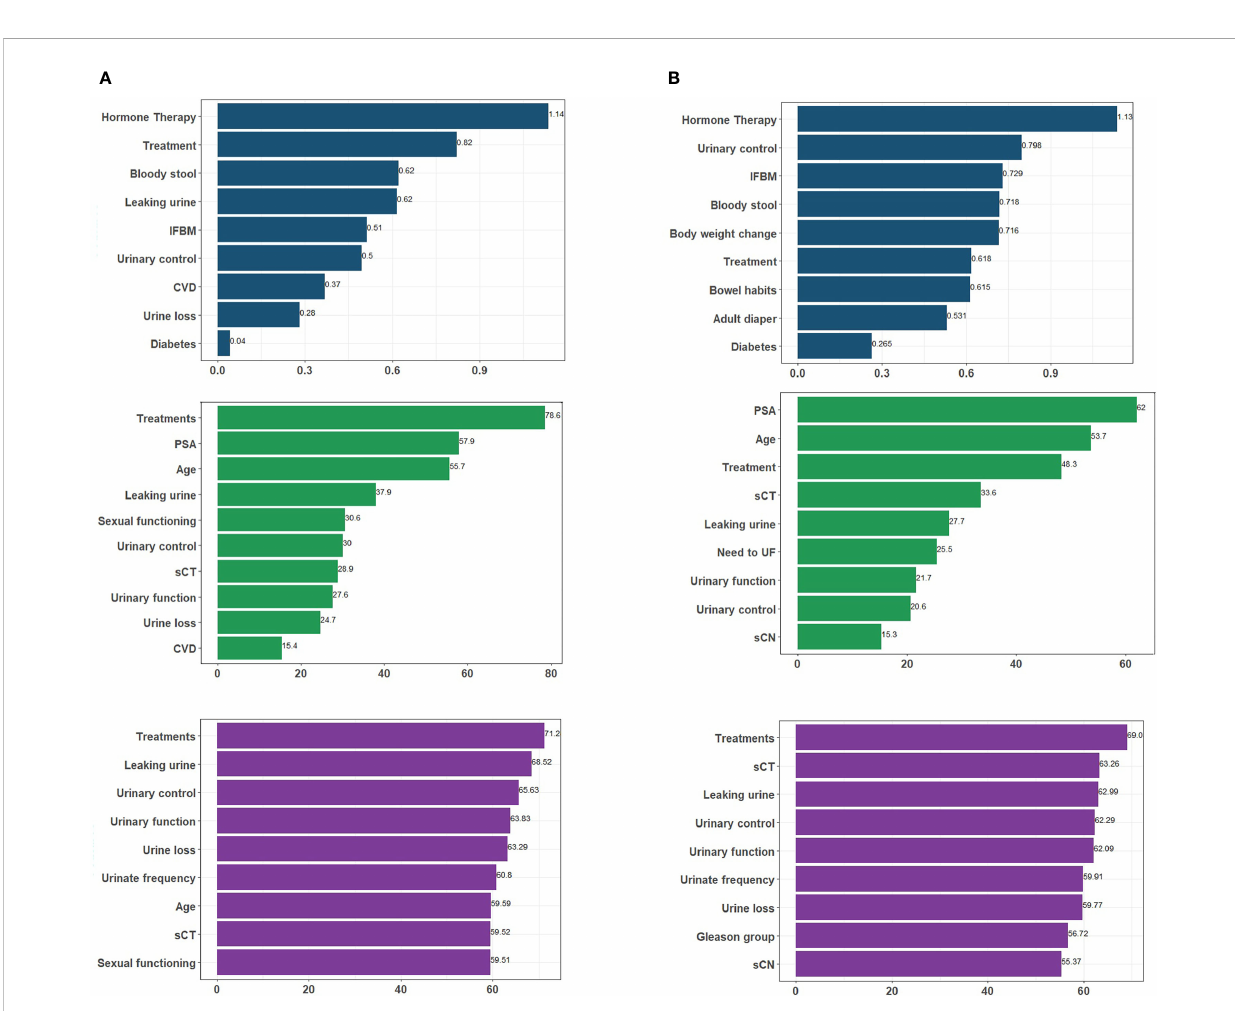
FIGURE 4 An overview of the most important variables selected by different algorithms, as well as their in fl uence levels. Each color represents predictors of a particular algorithm, i.e. dark blue for LR, green for RF, and purple for SVM for (A) 1-year; (B) 2-year follow-up. Treatment. IFBM, Increased frequency of bowel movement; PSA, prostate-speci fi c antigen; sCT, Tumor T stage; sCN, Tumor N stage; CVD, cardiovascular disease; UBM, urgency of have bowel movement; UF, urinate